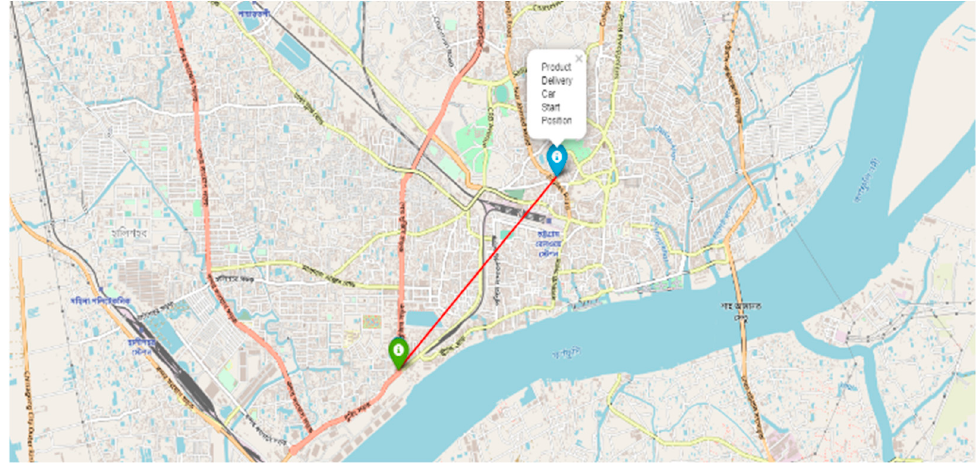
Figure 25. Map visualization of the source and destination place of the car.